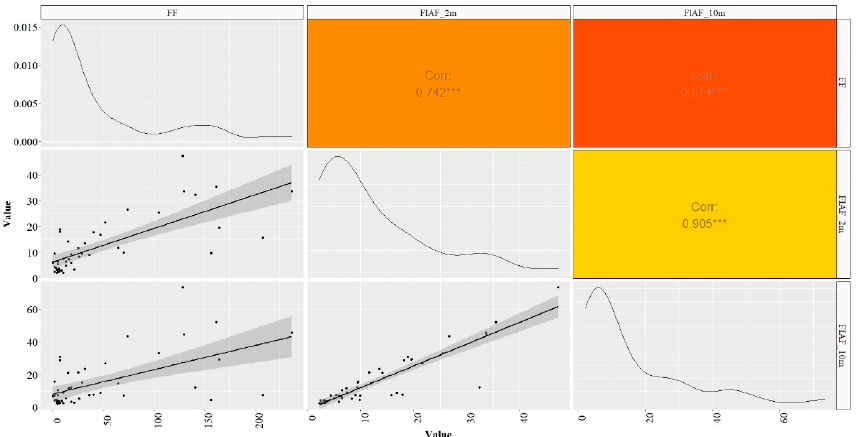
a value greater than 0.57 (Figure 6).